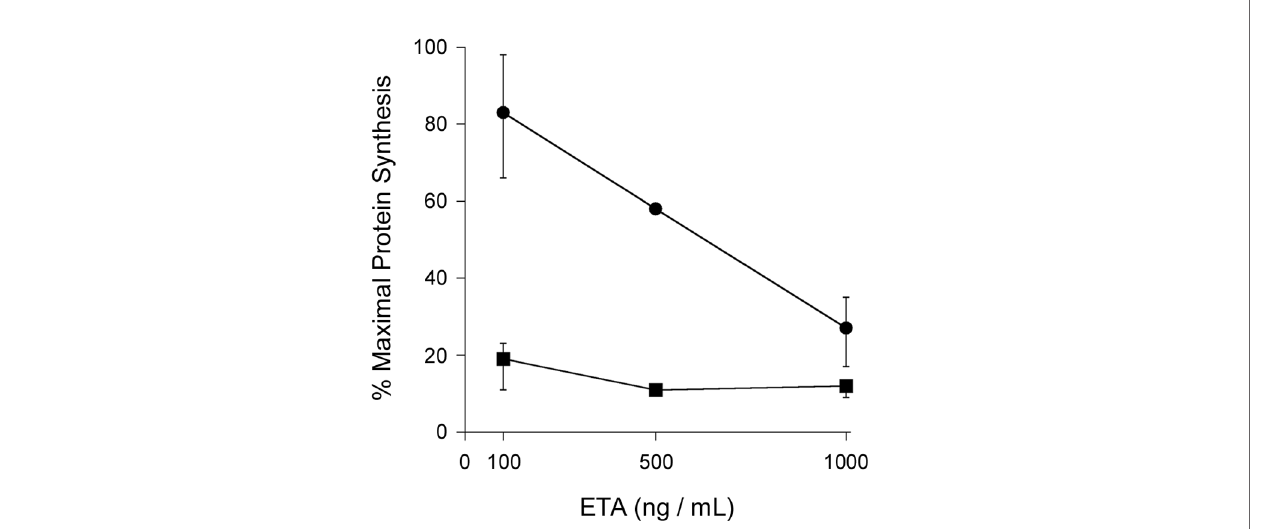
FIGURE 1 | PPI inhibition does not protect cultured cells from ETA. Untreated CHO cells (circles) and CHO cells treated with 10 m M of the cyclophilin inhibitor CsA (squares) were incubated with various concentrations of ETA for 4 h before the extent of protein synthesis was recorded. Maximal protein synthesis was established from parallel samples of unintoxicated cells. Data are presented as the averages ± ranges of 2 (500 ng/mL) or 4 (100, 1000 ng/mL) independent